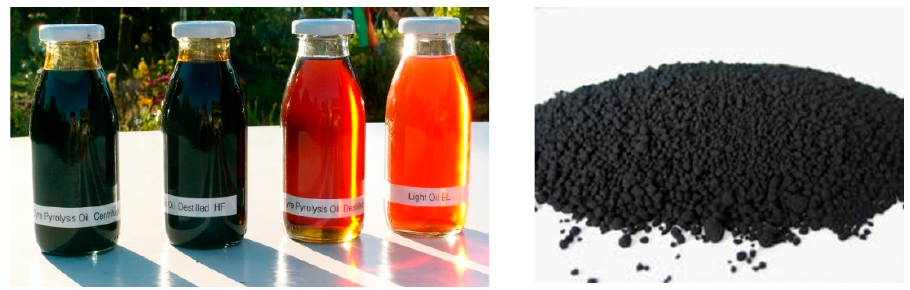
Figure 1. Tire pyrolysis oil and pyrolysis carbon